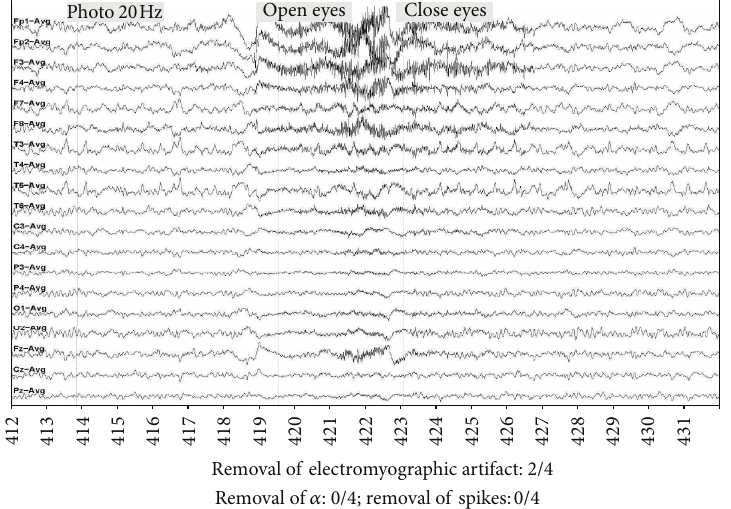
Figure 11: Filtering result with a 30Hz